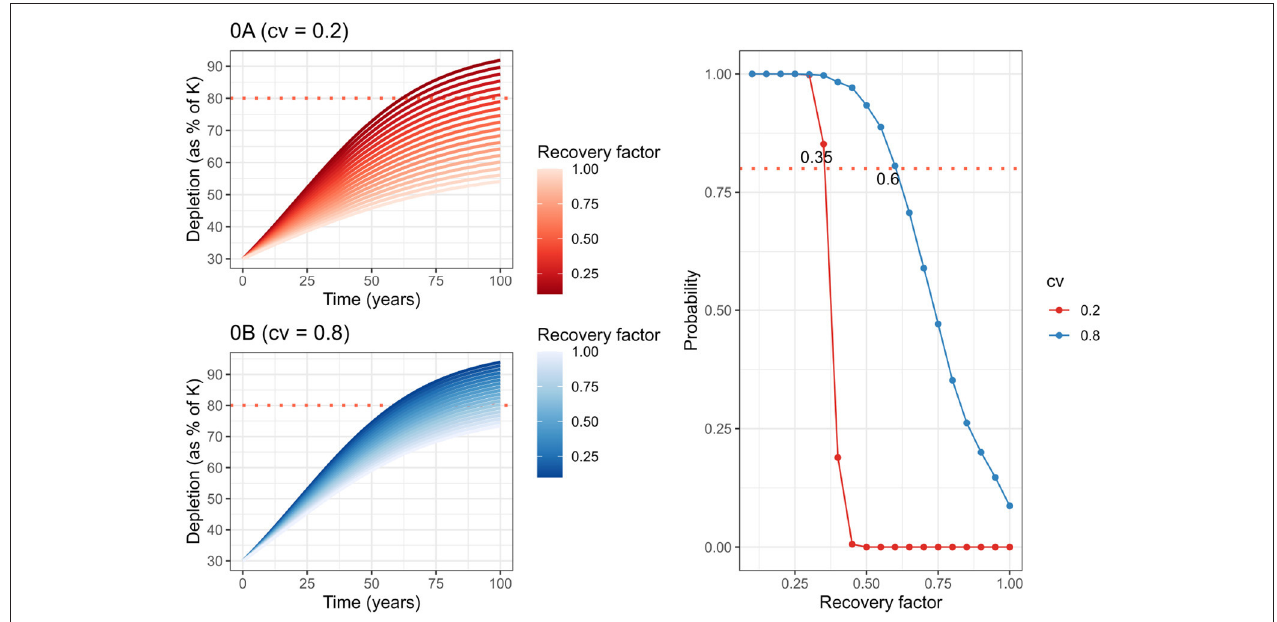
FIGURE 4 | Representation of recovery factor (F r ) impact on depletion level over time for the base case scenario (left) and probability of reaching Conservative Objective (CO) depending on the F r values (right).